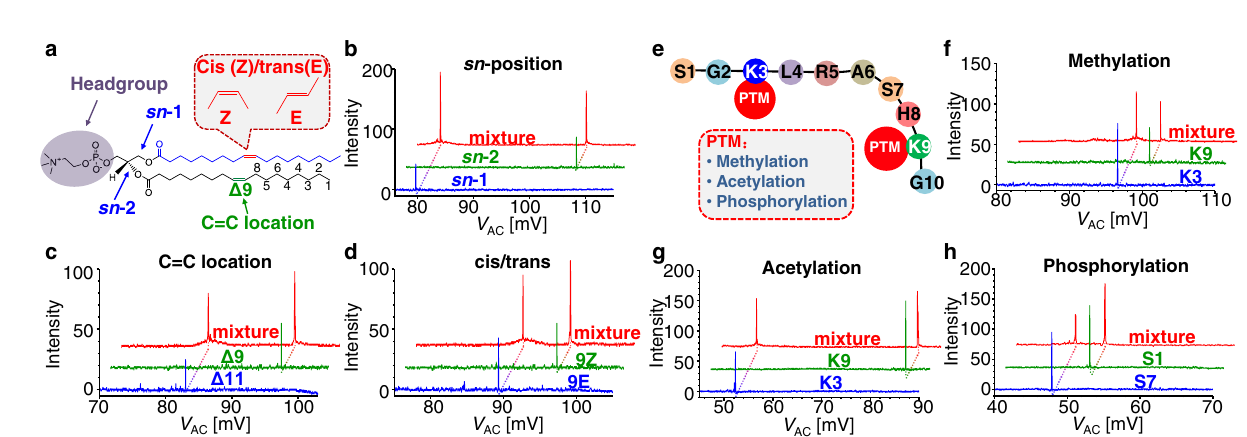
Fig. 3 | Structural analysis of lipids and peptides. a Structure of phospholipids with isomerization of sn position, carbon-carbon double bond location, and cis/ transstructureduetothedoublebond.Ioncloudpro fi lingspectraof b PC18:1(9Z)/ 16:0 (blue), PC 16:0/18:1(9Z) (green), and their mixture (red); c PC 18:1 (11Z)/ 18:1(11Z)(blue),PC18:1(9Z)/18:1(9Z)(green),andtheirmixture(red); d PC18:1(9E)/